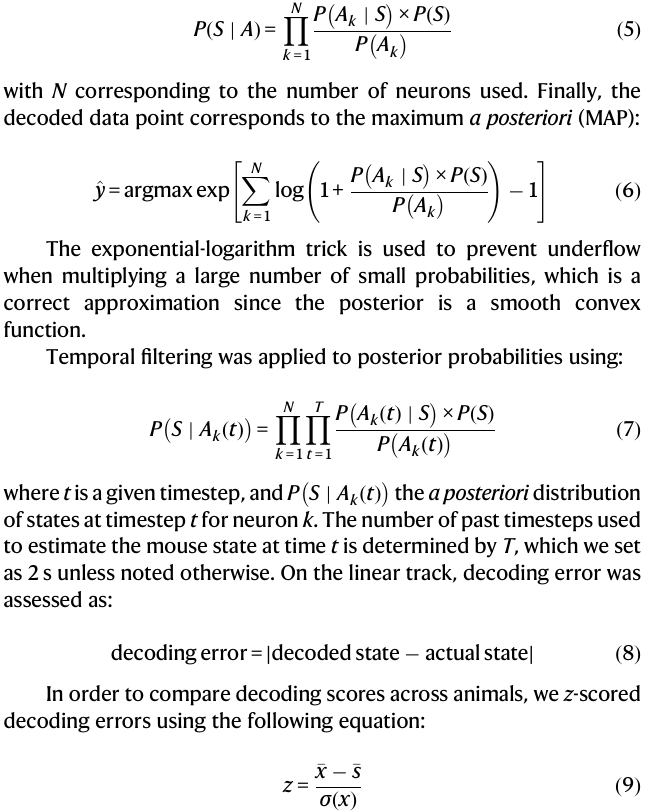
parameters:gSig = 3pixels(widthofgaussiankernel),gSiz = 20pixels (approximate neuron diameter), background_model = ‘ ring ’ , spatia- l_algorithm = ‘ hals ’ , min_corr = 0.8 (minimum pixel correlation threshold), min_PNR = 8 (minimum peak-to-noise ratio